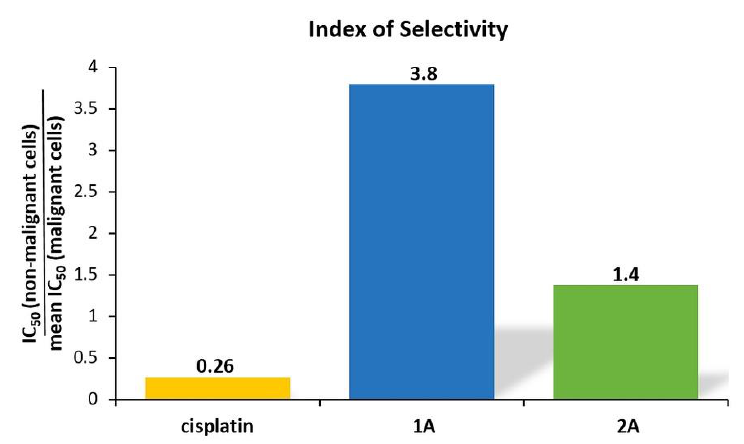
Figure 10. Index of selectivity of 1A , 2A , and cisplatin presented in arbitrary units against the IC 50 values determined in non-malignant cell line HEK-293T.